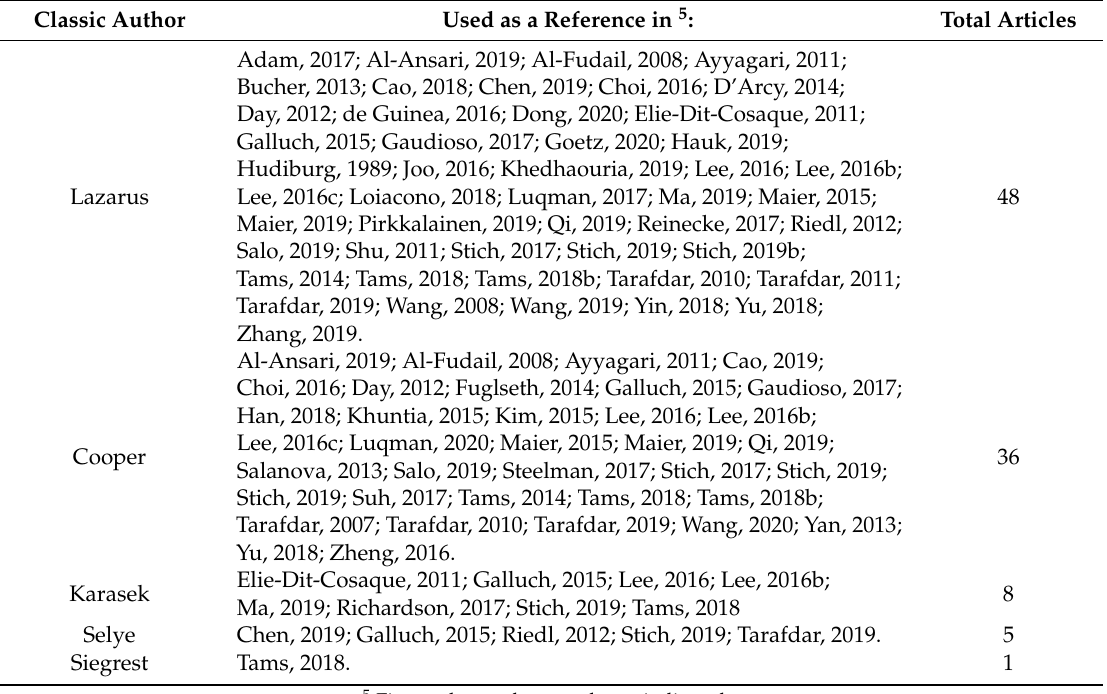
Table A2. Complete reference